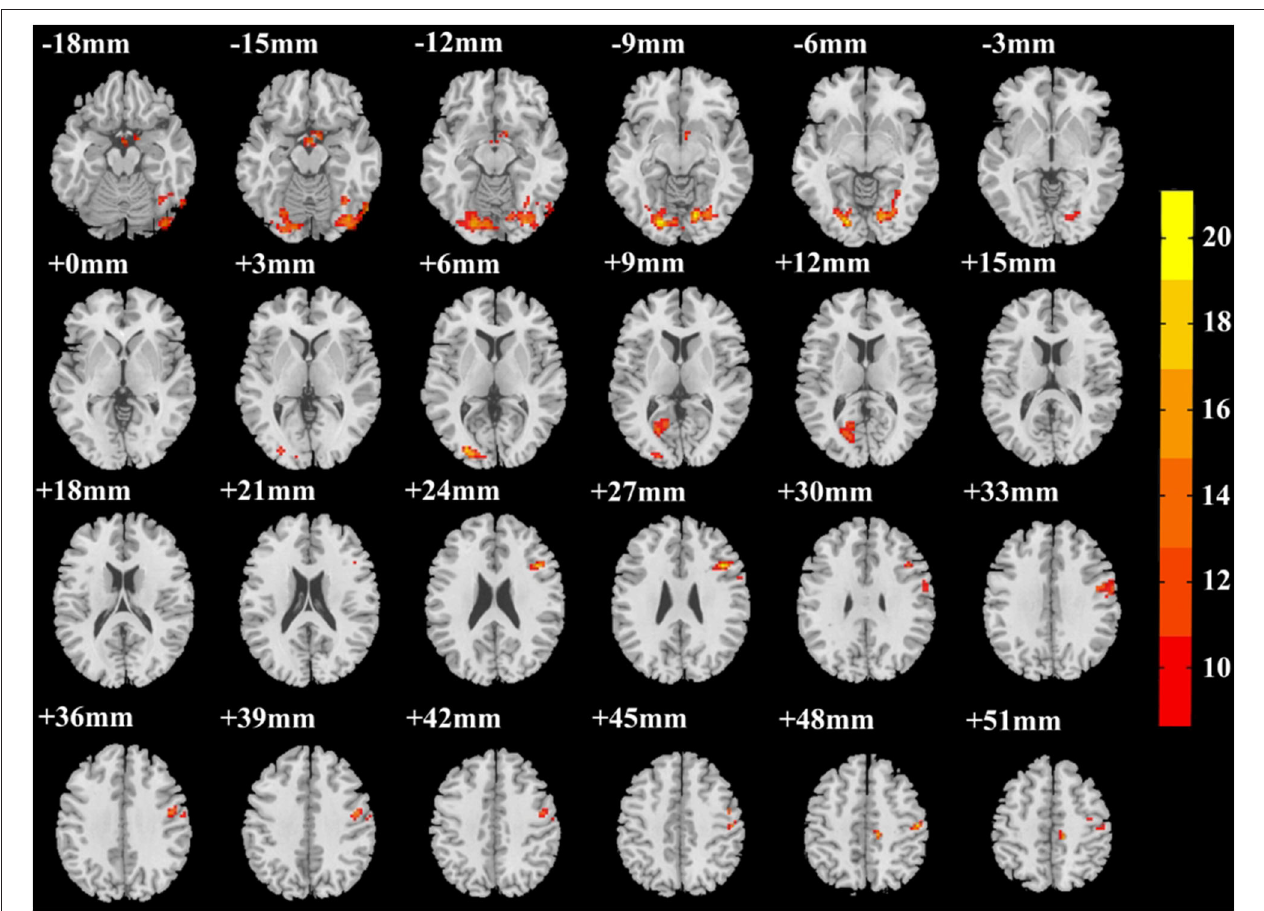
FIGURE 1 | Group differences in ALFF among three groups (SF, NSF, and HCs). A significant group effect was found in the right fusiform gyrus, left fusiform gyrus, left middle occipital gyrus, right inferior frontal gyrus, right precentral gyrus, right postcentral gyrus, and left calcarine sulcus (correction with Gaussian random field, voxel p < 0.001, cluster p < 0.05,